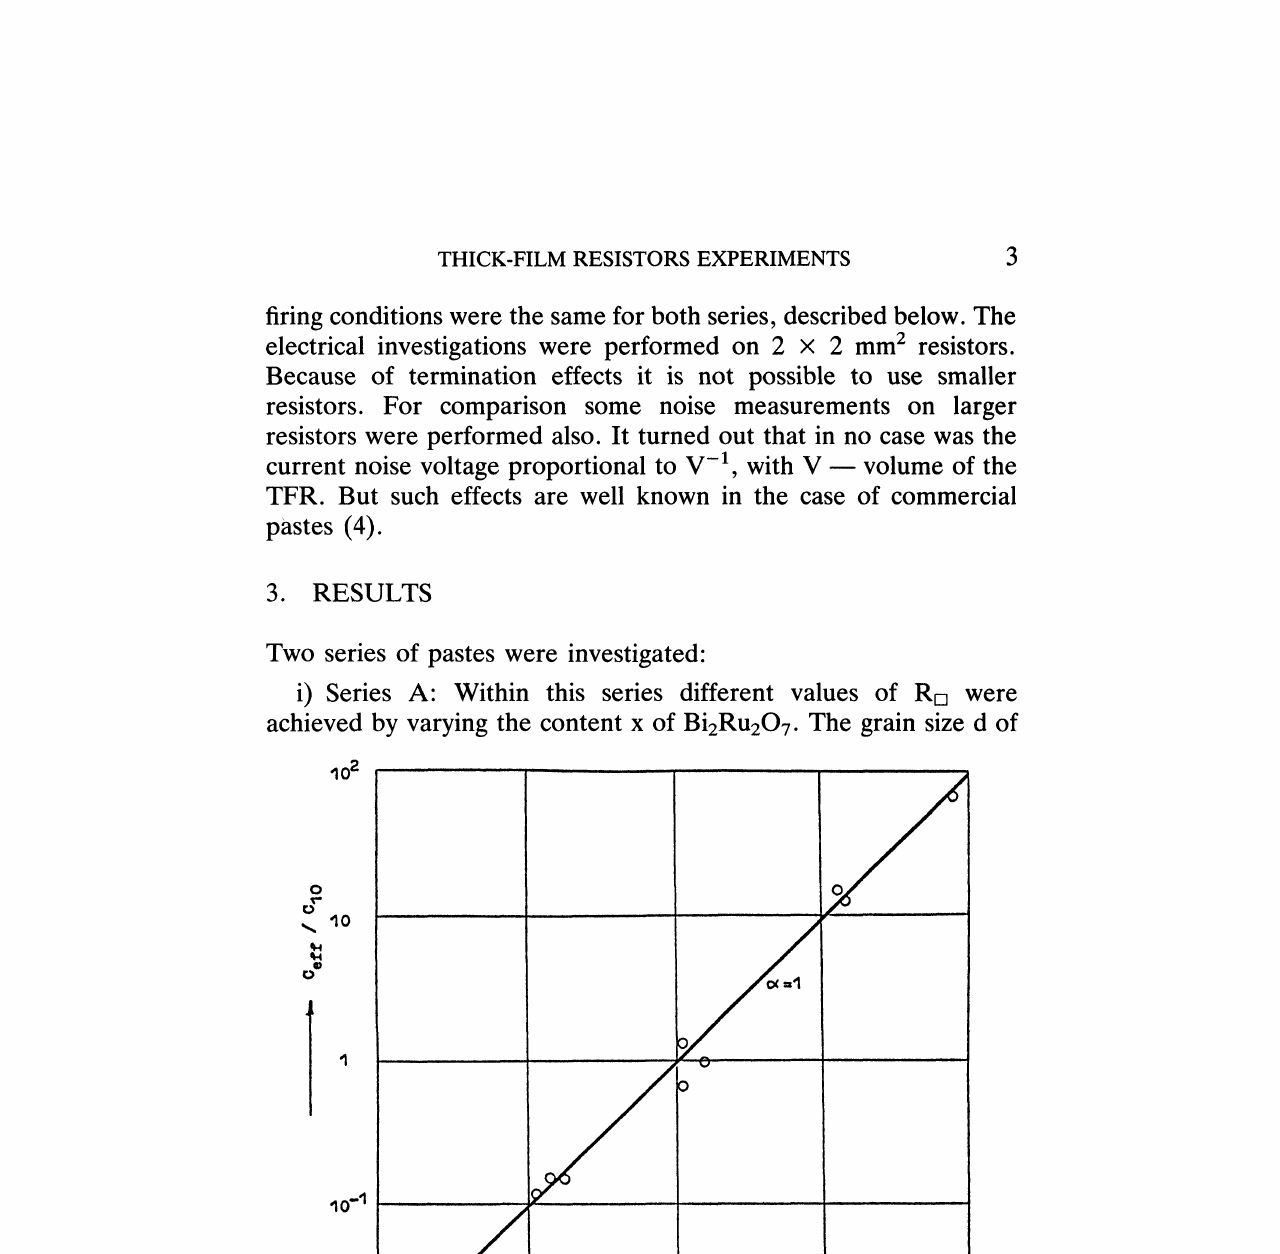
10-2 ’10 2 10 FIGURE Dependence of current noise behaviour on sheet resistivity R[]. Different R[] have been achieved by varying the content of ruthenate. CIo C+rr (R[] I/]-ff k/l-I).